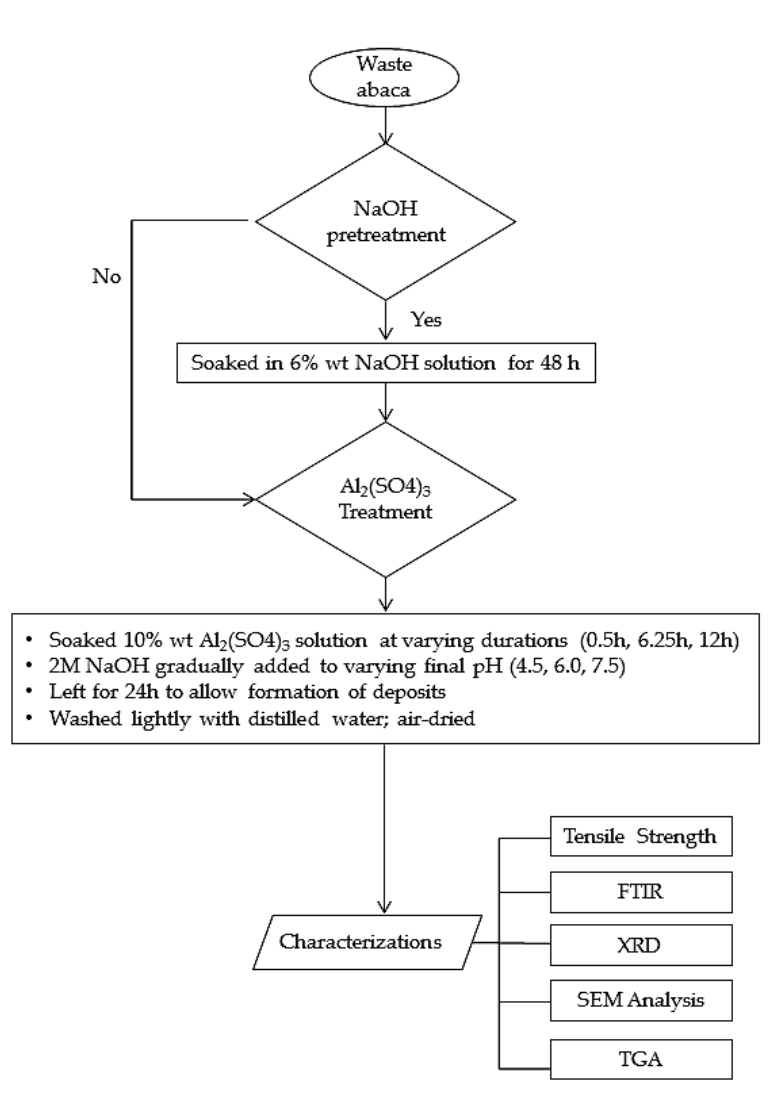
Figure 2. Chemical treatment and characterization of waste abaca fiber.